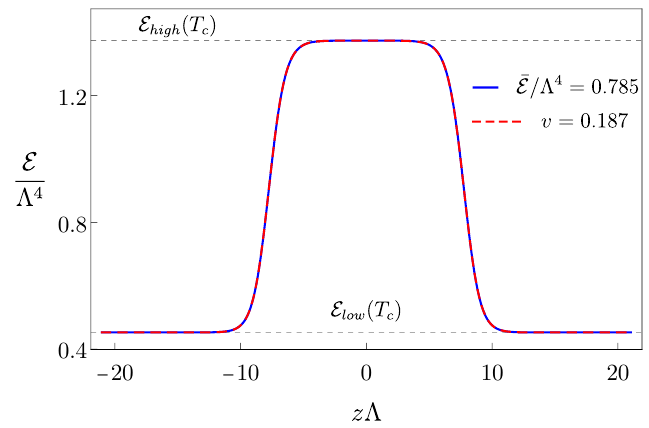
Figure 7 . Comparison of the energy profile obtained by Lorentz-transforming the curve in figure 6 (dashed, red curve) with a configuration obtained directly as an inhomogeneous, static configuration with the same average energy (3.5) in a box of size L 0 = γL (solid, blue